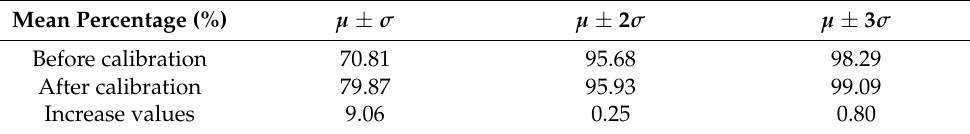
Table 1. The mean percentages of P2P-D for 64 laser beams according to 3 σ criterion.